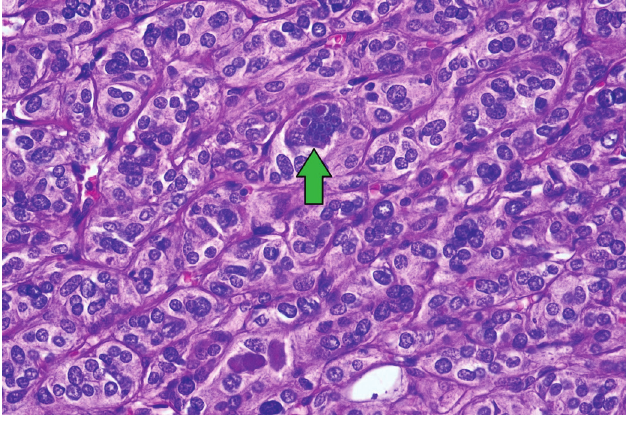
Figure 4 A - The anaplastic carcinoma.(HEx100) Figure 4 B - A giant bizarre nuclues (green arrow) including conspicious nucleoli in the anaplastic